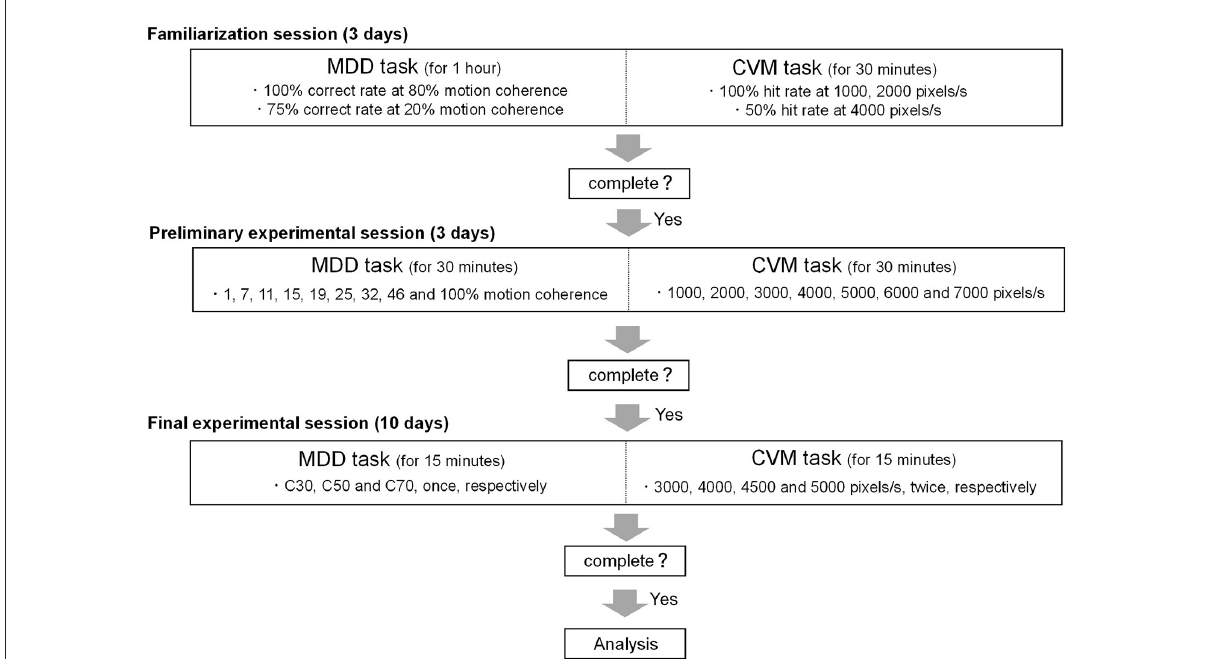
FIGURE3 Schematic overview of the experimental protocol. The study was composed of a familiarization session (3 days), a preliminary experimental session (3 days) and a final experimental session (10